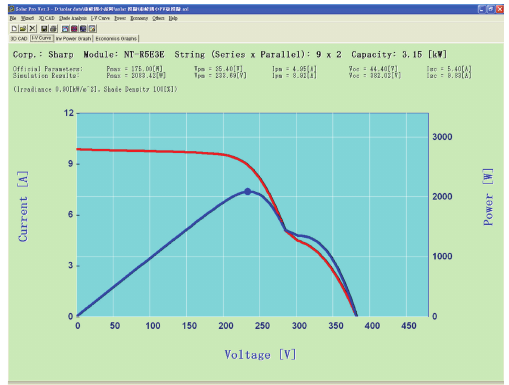
Figure 5: Simulated I-V and P-V curves of a photovoltaic power module array when two modules were shaded, the irradiation was 900 W/m 2 , and the PV module surface temperature was at 51.6 ∘